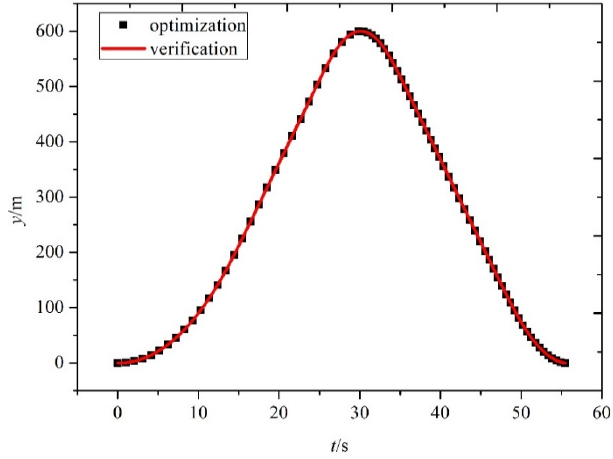
Figure 4. Flight height in the first scenario vs. time.